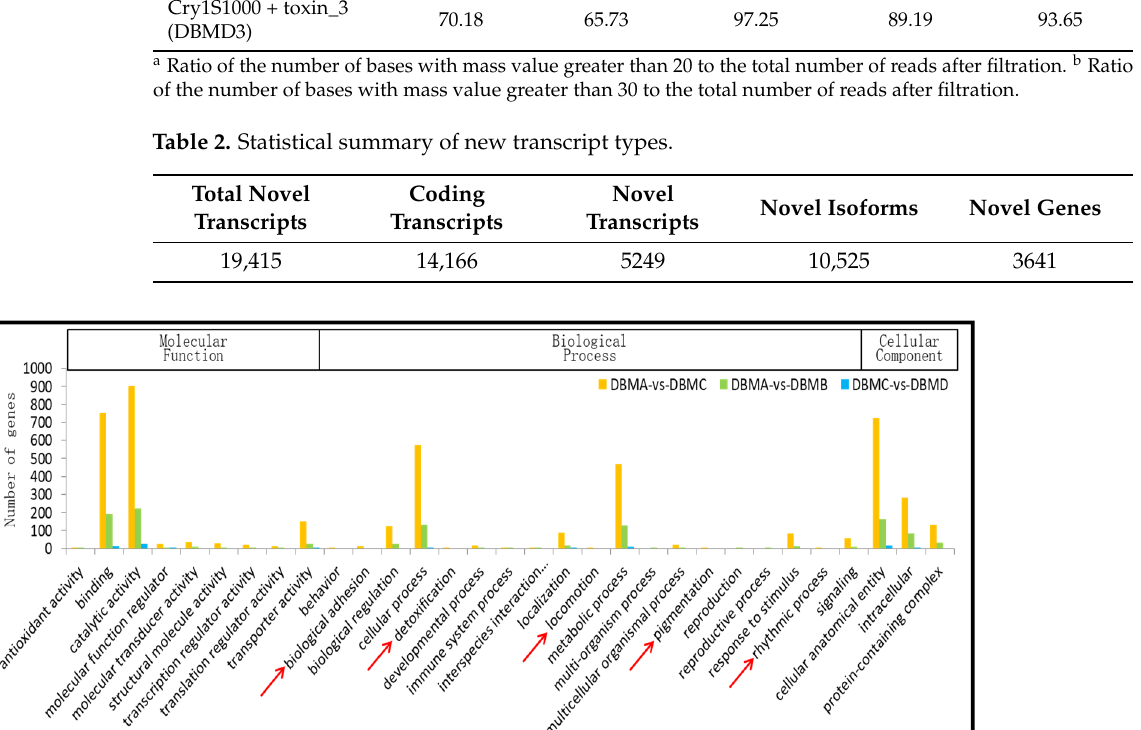
Figure 1. Histogram presentation of gene ontology (GO) classification between any two groups from susceptible, resistant, and two toxin-treated strains. The GO categories shown on the X -axis are divided into three main ontologies: molecular function, biological process, and cellular component. The Y -axis indicates the number of DEGs in each category. DBMA represents G88-susceptible strain; DBMB represents G88-susceptible strain with toxin treatment; DBMC represents Cry1S1000-resistant strain; DBMD represents Cry1S1000-resistant strain with toxin treatment. GO analysis showed that the distribution patterns of DEG function categories in each group were basically consistent, except for “biological adhesion”, “detoxification”, “locomotion”, “pigmentation”, and “rhythmic process” (red arrows), between susceptible and resistant strains.